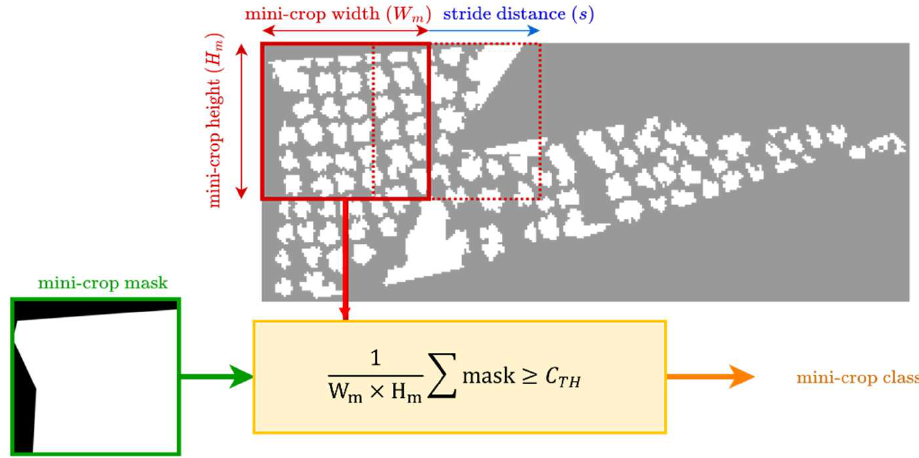
Figure 5. Operation diagram for the mini-crop segmentation method where C TH defines the threshold for validating mini-crops